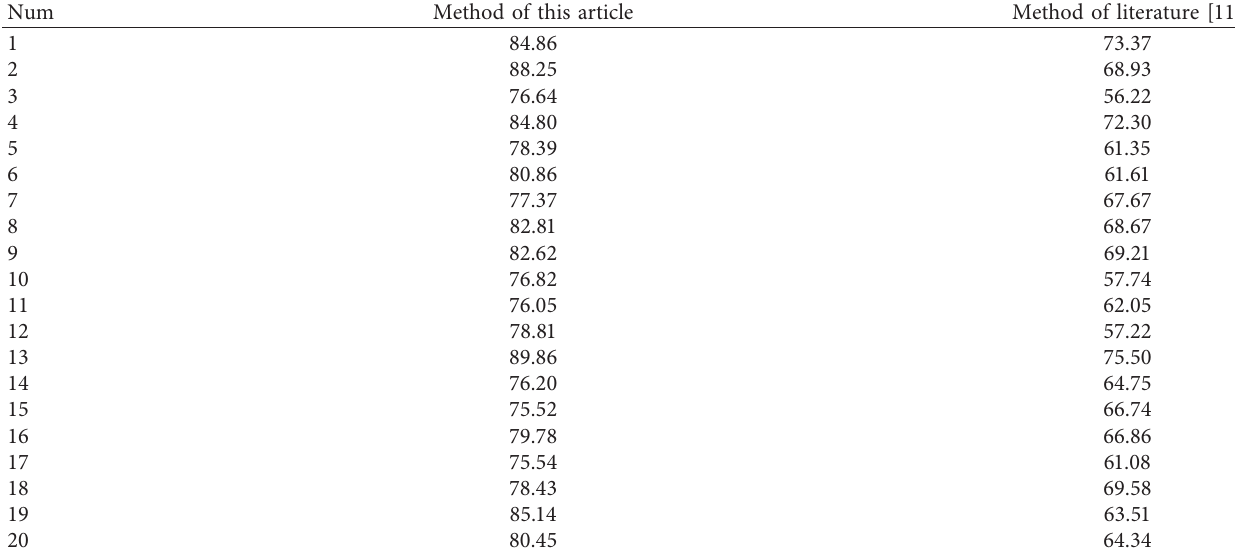
Table 2: Music teaching effect comparison.